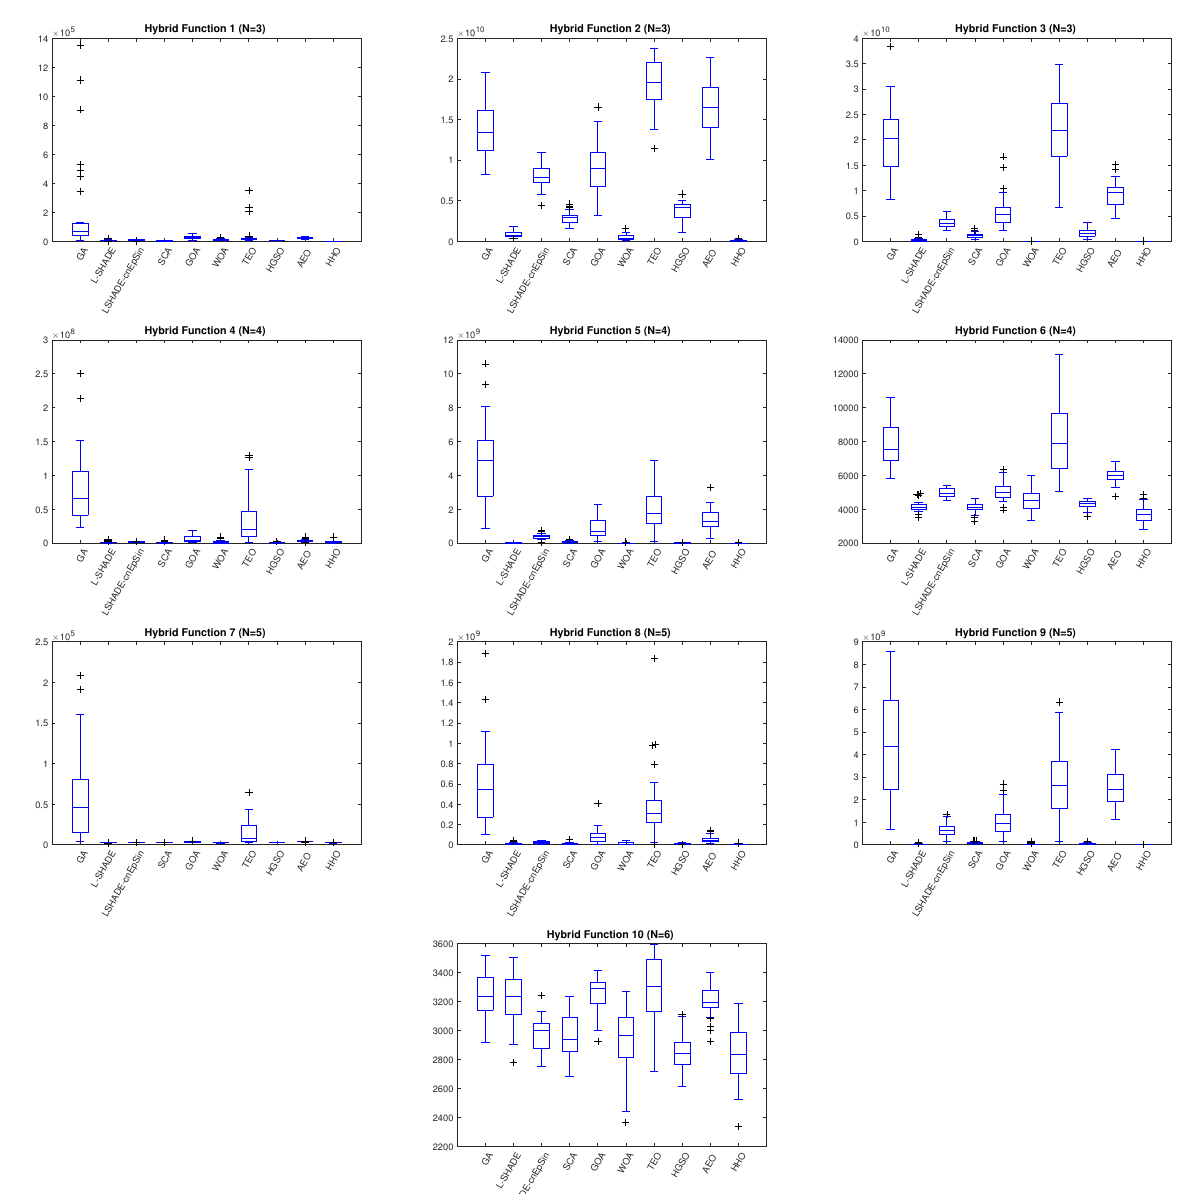
Figure 10. Boxplot of some functions from F11–F20 for all